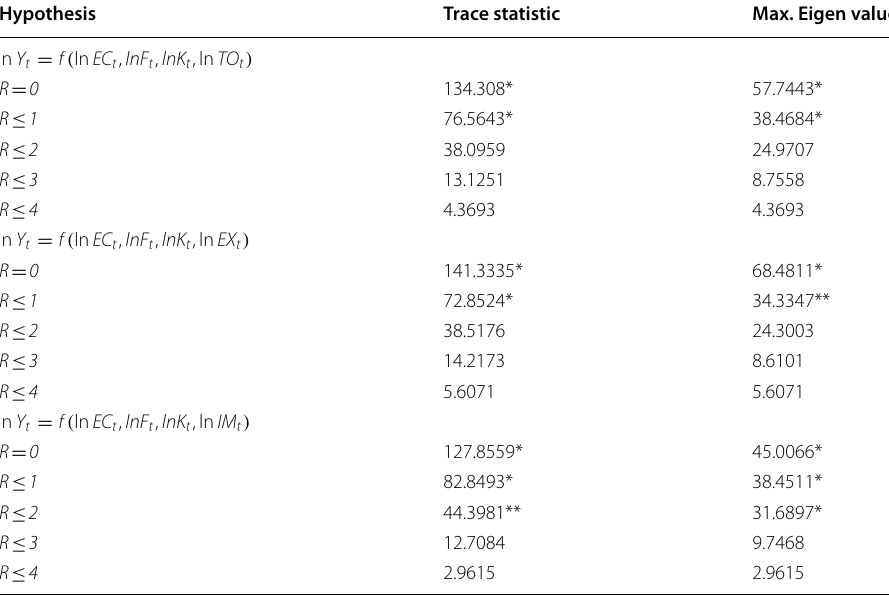
Significant values at 1% and 5% levels are indicated by * and **, respectively